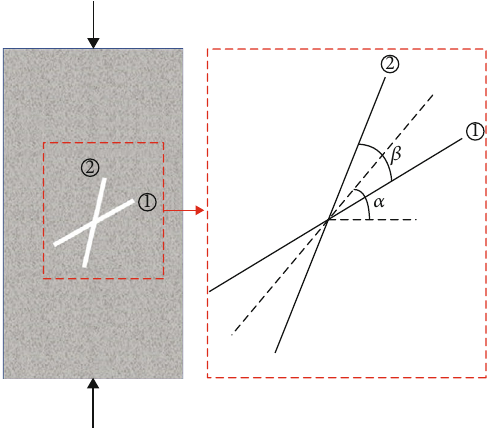
Figure 6: The layout of X-shaped fi ssure.